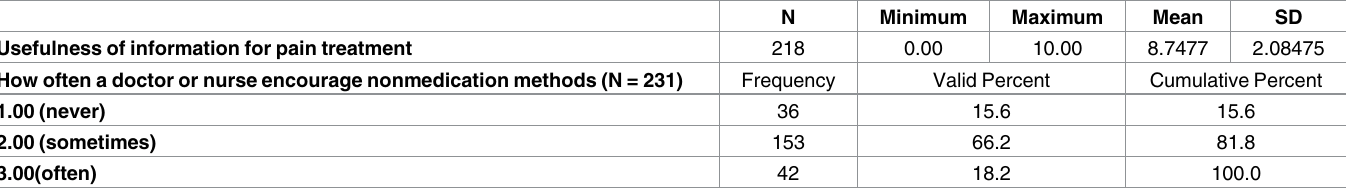
Table 8. Usefulness of receivedinformation and frequency of nonmedication methods encouragement.